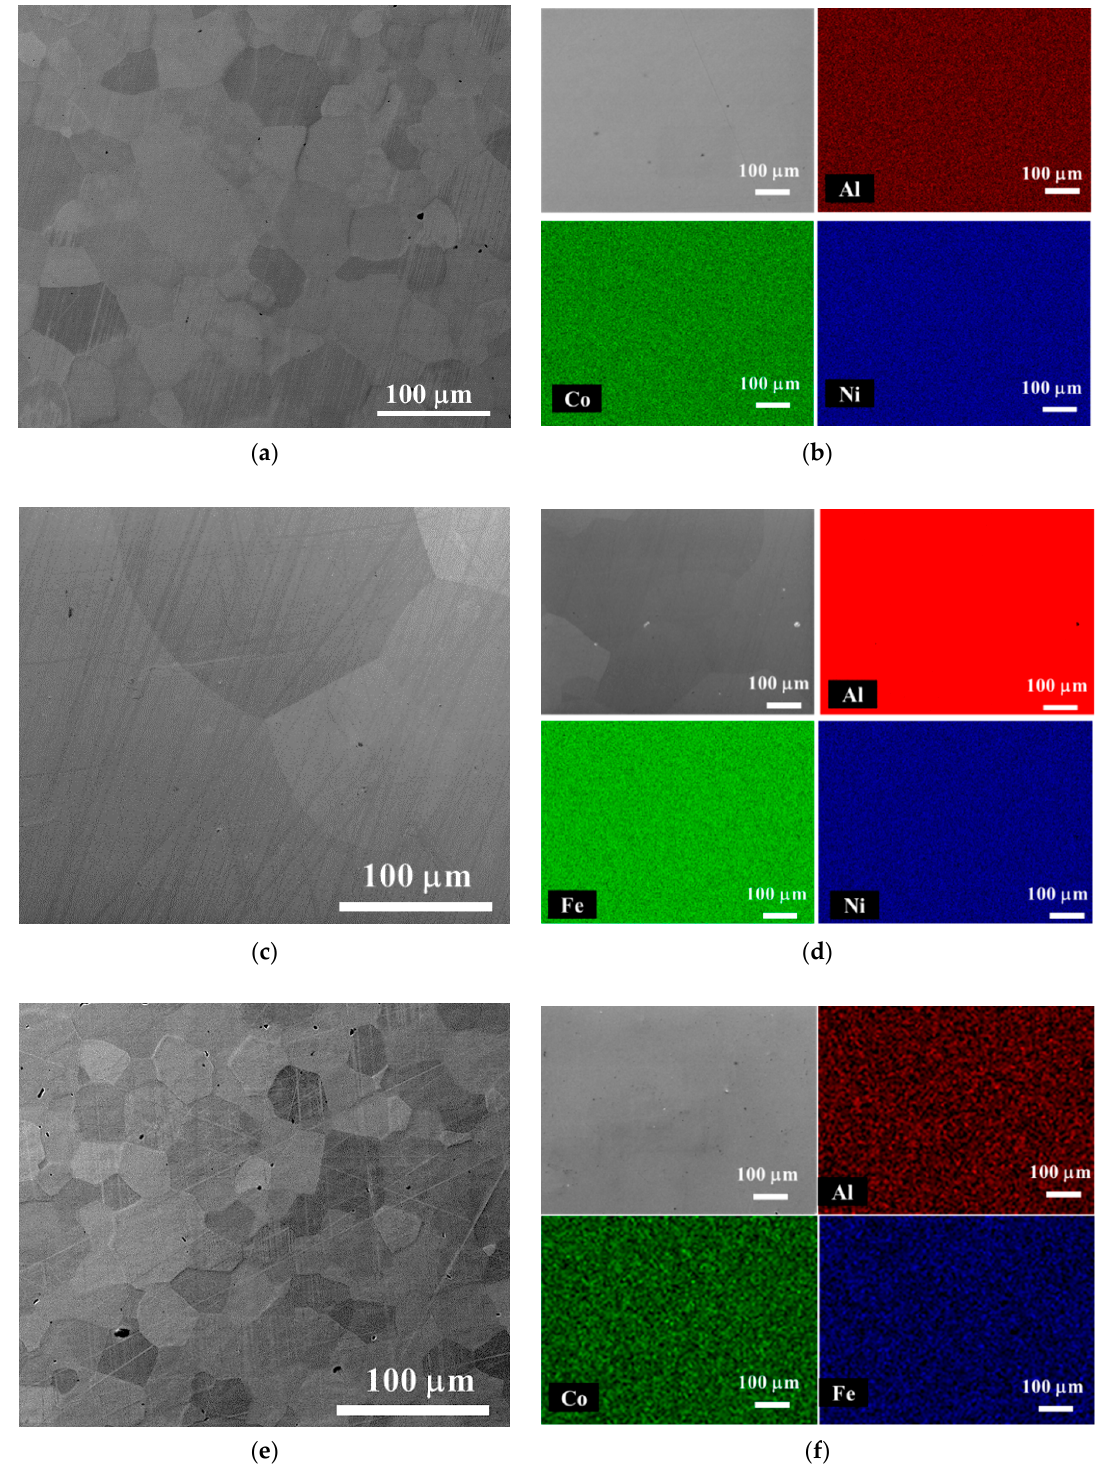
Figure 7. SEM-BSE image and corresponding elemental mapping of ( a, b ) Al(CoNi), ( c, d ) Al(FeNi), and ( e, f ) Al(CoFe) ternary alloys homogenized at 1373 K for 144 h.